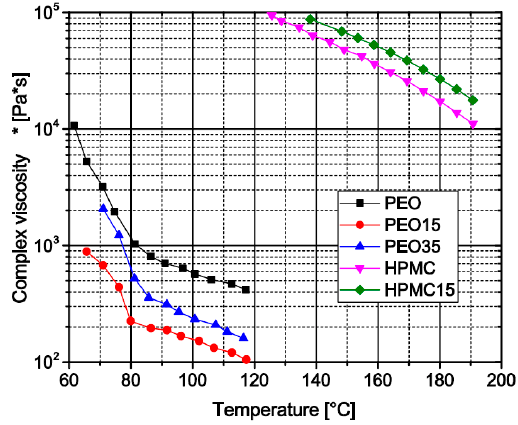
ff erent filament formulations (heating Figure 7. Oscillatory melt viscosity of different filament formulations (heating graph). Figure 7. Oscillatory melt viscosity of di